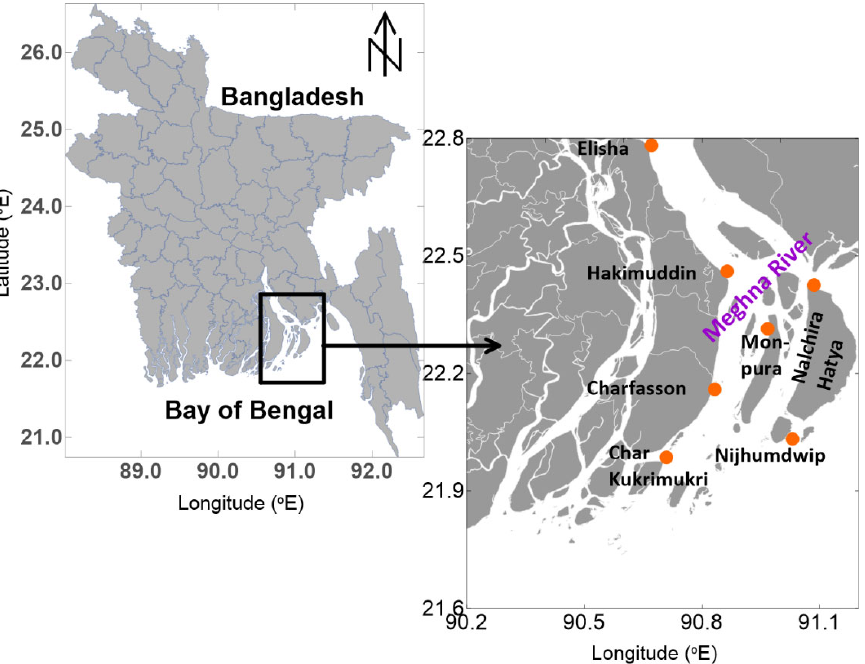
Figure 1. Map of the study area.